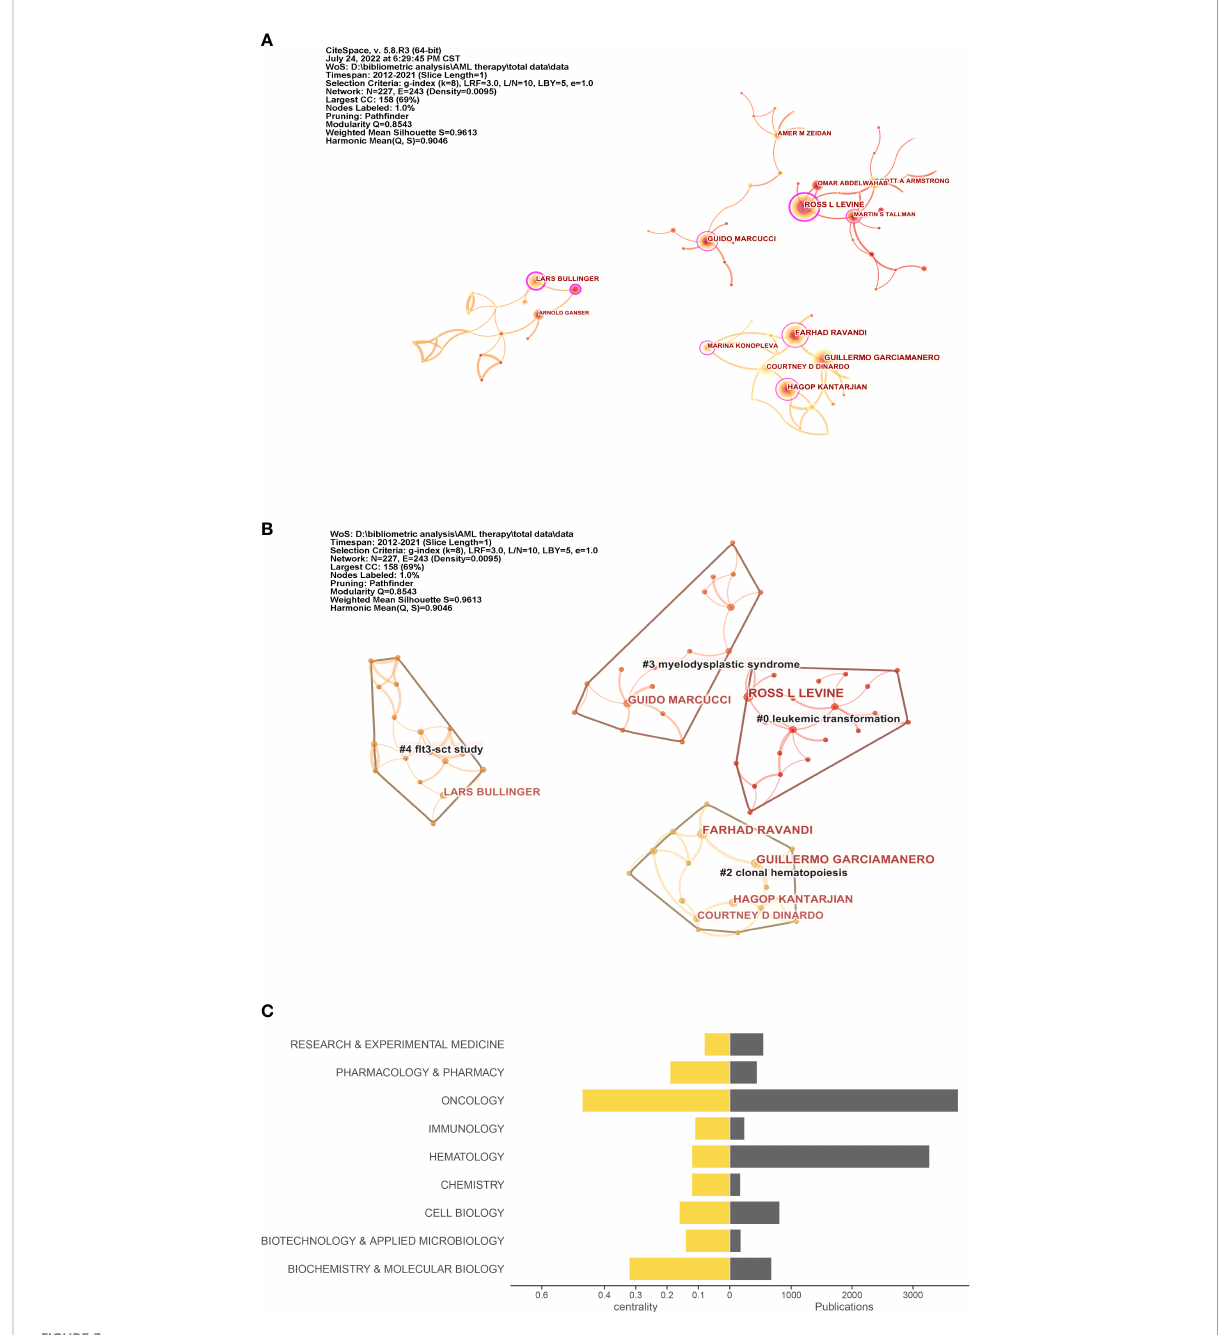
FIGURE 3 Co-author and category analysis. (A) Co-author network. The circle in (A) indicates the author; the larger the size of the circle, the higher the number of citations of the author. (B) Clusters of the co-author network. (C) Top 10 topics for publications. The right axis is the publication, and the left axis is the BC